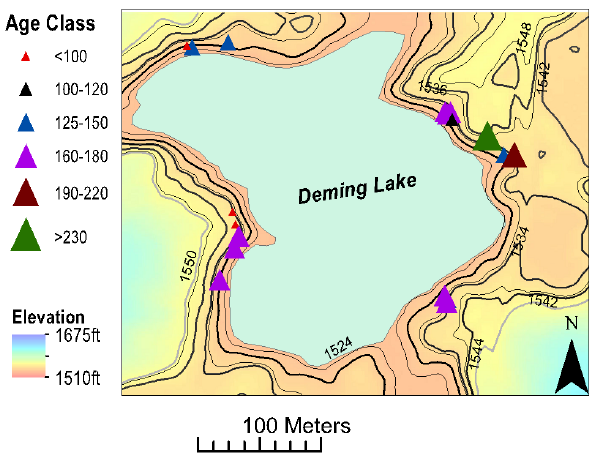
Figure 1. The Deming Lake watershed, looking west-southwest. P. resinosa and P. strobus are the most common species in this area, though understory vegetation includes smaller hardwoods, shrubs, and various grasses. Photo credit: Amy Myrbo.